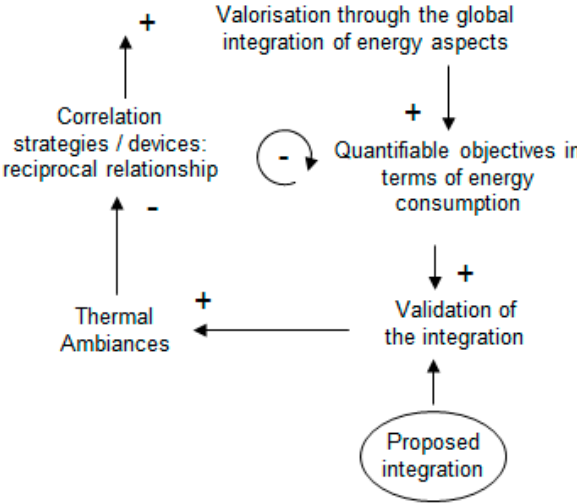
Figure 2. The realization loop of the conceptual process relating to the thermal comfort. Case of correlation of strategies and devices.